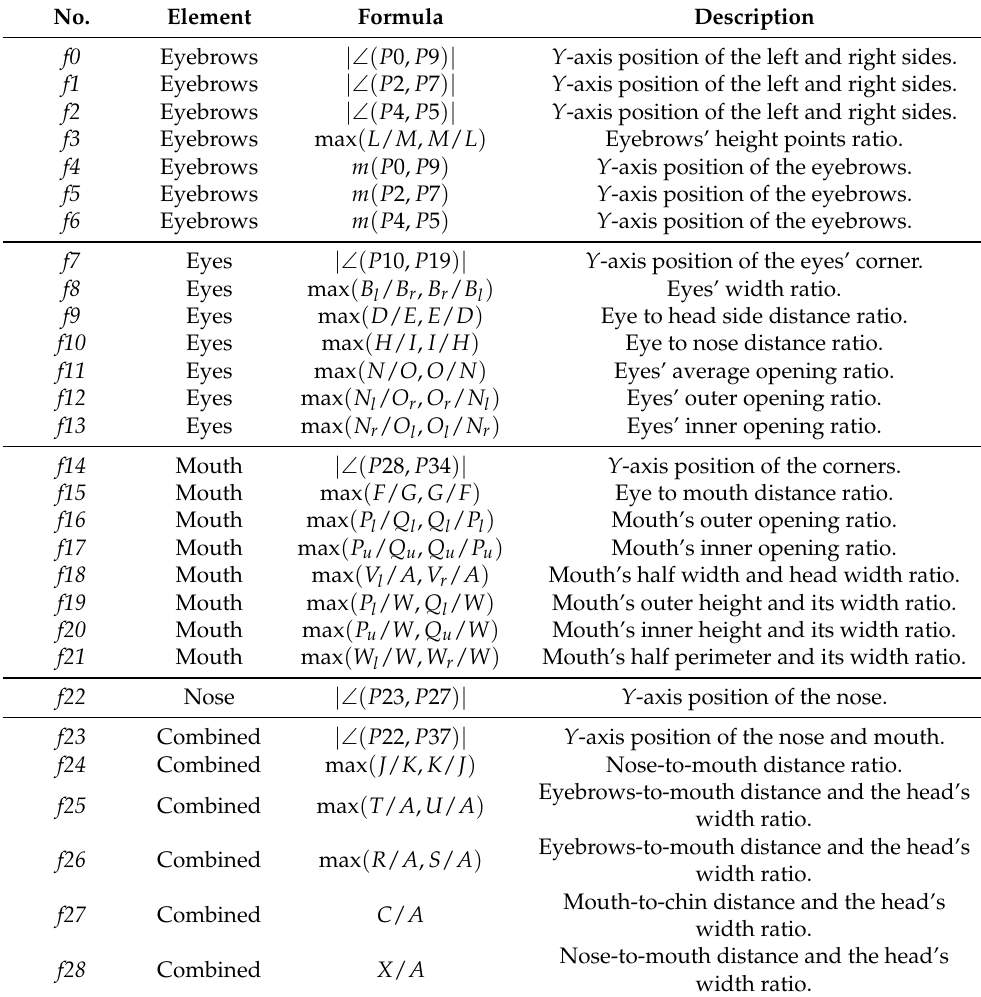
Table 2. Facial features introduced by Parra et al. in